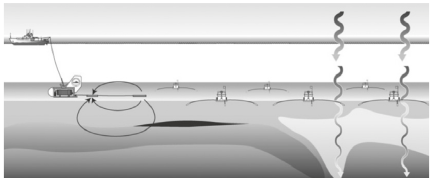
Figure 1: Schematic diagram of operation method of marine controlled-source electromagnetic